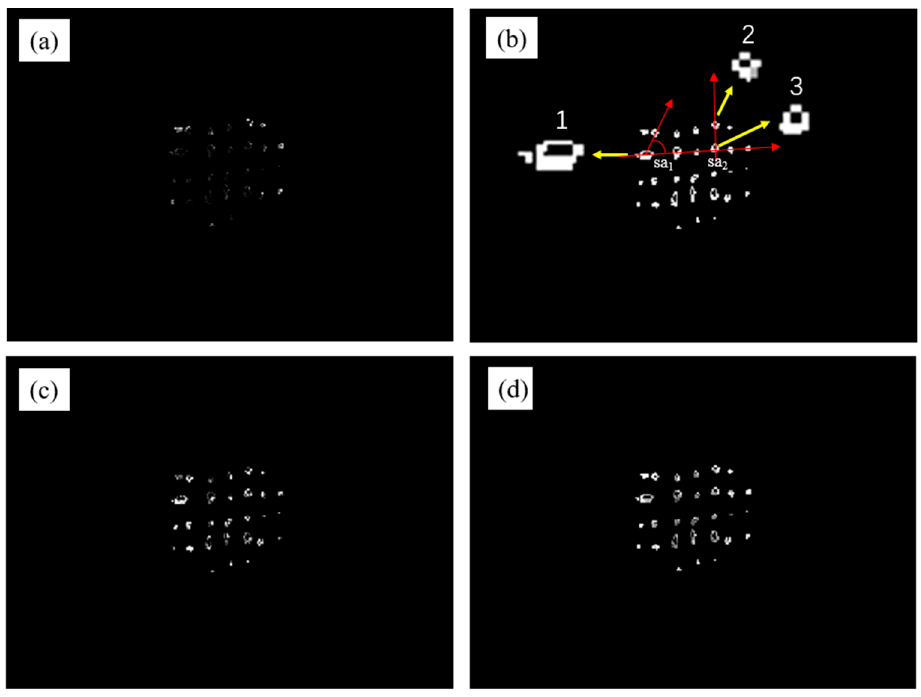
Figure 5. The polarization images. ( a ) The image of depolarization coefficient; ( b ) the image of η 2 ; ( c ) the image of η 3 ; ( d ) the image of abs ( η 4 ) .